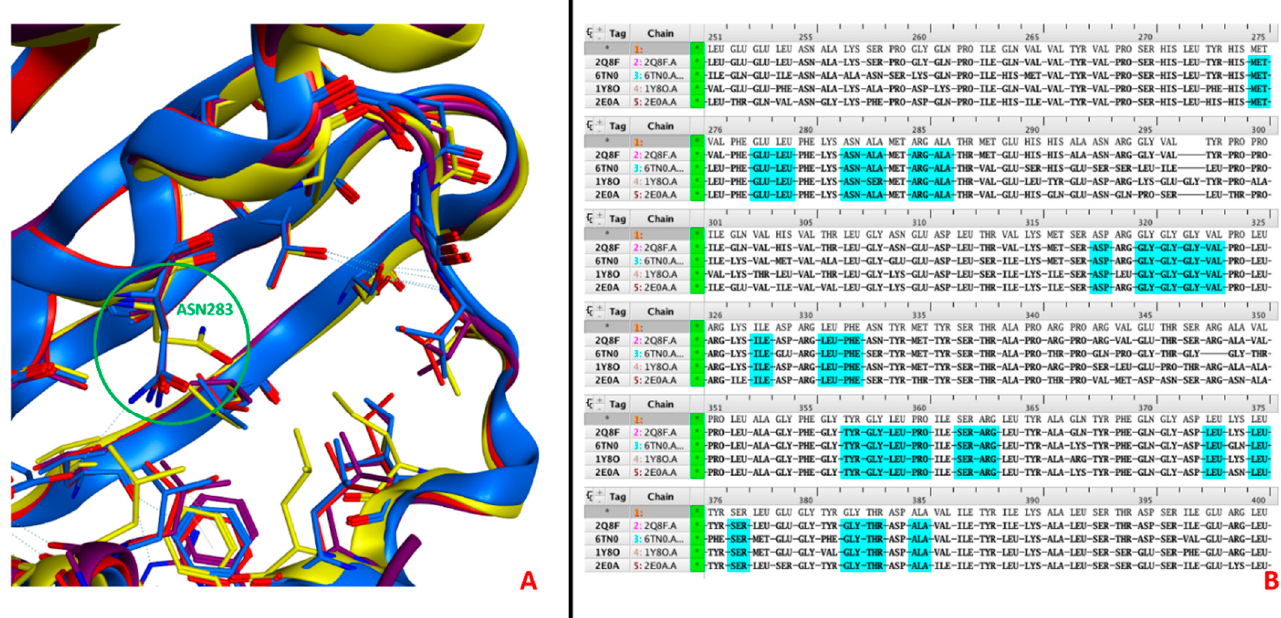
Figure 7. ( A ). The ATP-binding pocket of the four PDK isoforms aligned and superimposed to one PDK1. Looking into the detail, the crystal structures used were: 2Q8F for PDK1 (colored in yellow), 6TN0 for PDK2 (method: X-ray diffraction, resolution: 1.91 Å, colored in blue) [45], 1Y8O for PDK3 (method: X-ray diffraction, resolution: 2.48 Å, colored in red) [46], and 2E0A for PDK4 (method: X-ray diffraction, resolution: 1.86 Å, colored in purple) [47]. For each crystallographic structure, the very same preparation procedure described at the beginning of the section for PDK1 and HSP90 was exe- cuted. The residues depicted in sticks are helpful in giving a representation of the very high level of similarity among the ATP-binding pockets of the different PDK isoforms, which becomes absolute